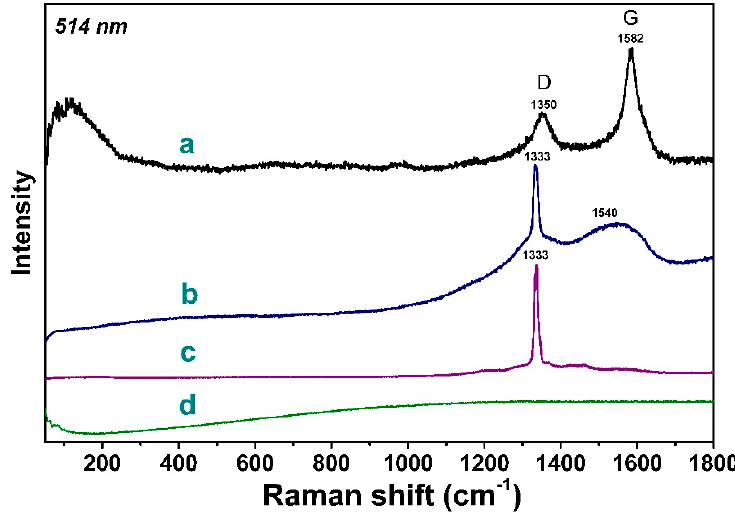
Figure 3. Raman spectra of Sample 1 ( a ), Sample 2 ( b ), and Sample 3 ( c ) grown at different parameters of gas-jet synthesisin comparison with the spectrum of initial Mo substrate ( d ).